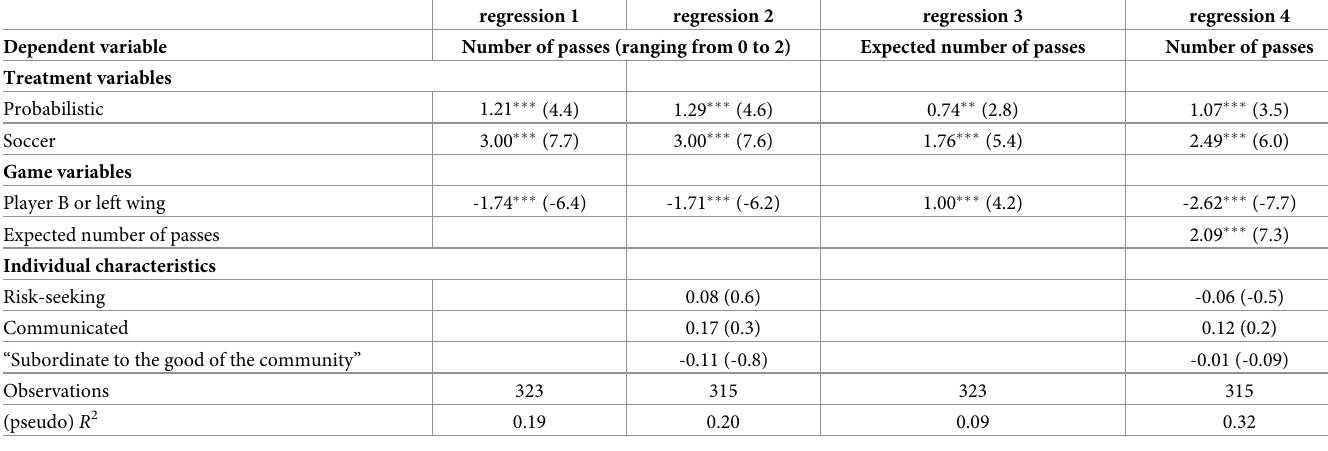
Table 2. Ordered logit regressions on subject’s number of